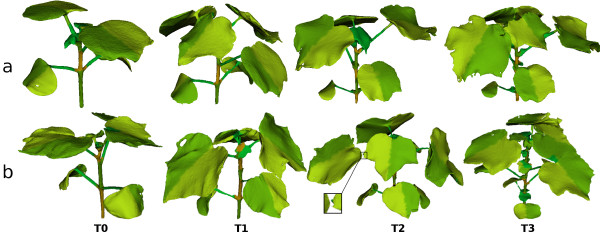
Examples of plant segmentation resultsIllustration of the segmentation of two Gossypium hirsutum cotton plant (a) and (b) studied over 4 time-points. As shown by the segmentation of the plant b at 
T2and 
T3the algorithm is robust to reconstruction issues such as floating mesh parts (typically leaves), and two leaves merges together.